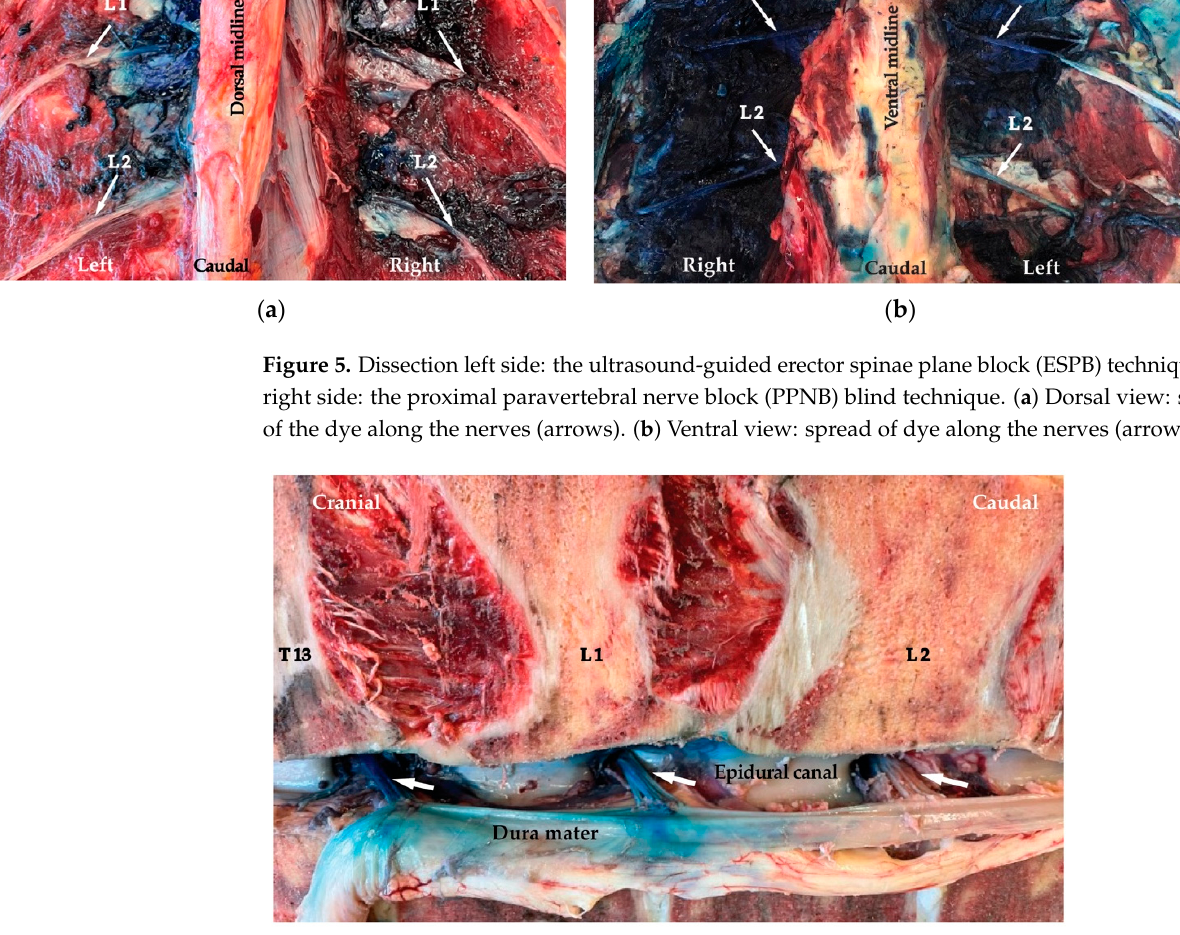
Figure 6. Staining of the dorsal roots of spinal nerves from T13 to L2 (arrows) on the right side (from blind proximal paravertebral nerve block (PPNB) low-volume (20 mL) group) after displacement of the Medulla spinalis. Note the staining of the Dura mater.